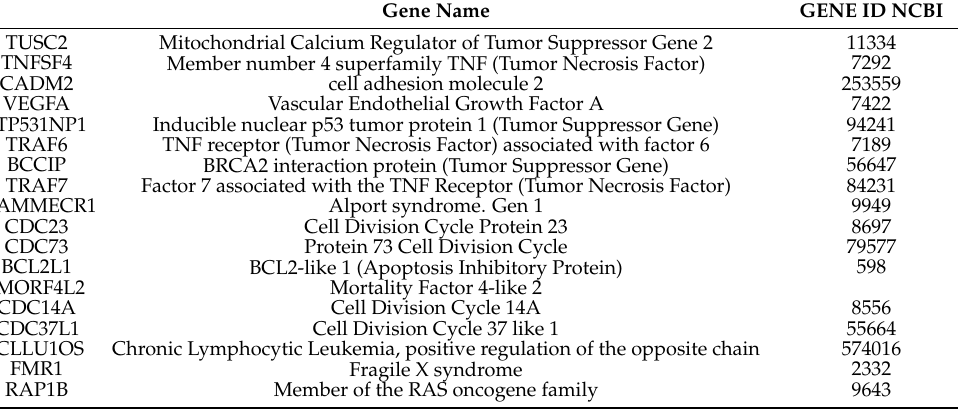
Table 4. Targets of